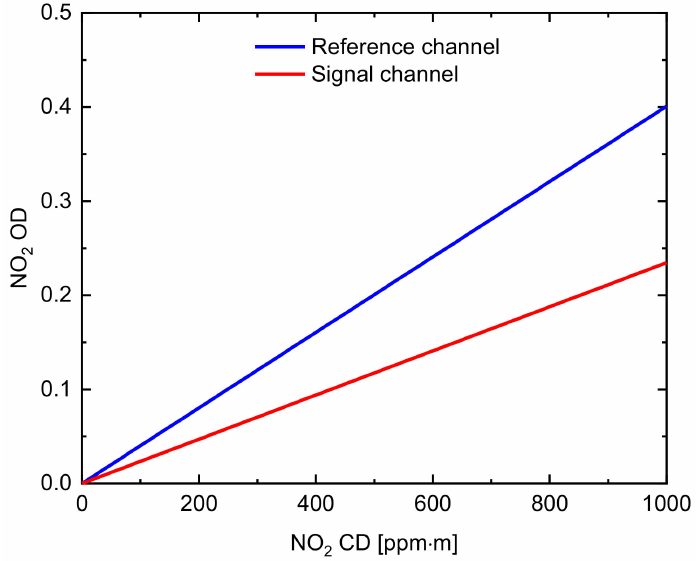
Figure 7. Relationship curve between the corresponding NO 2 CD and the NO 2 optical depth (OD).